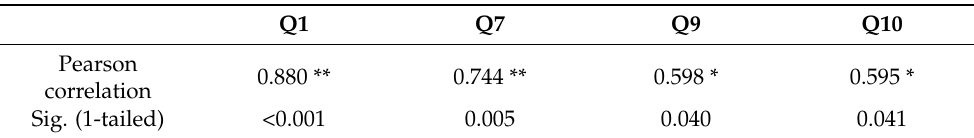
Table 9. Correlations between participants’ level of expertise with HCI design patterns and answers of Q1, Q7, Q9, and Q10. Q1 Q7 Q9 Q10 Pearson 0.880